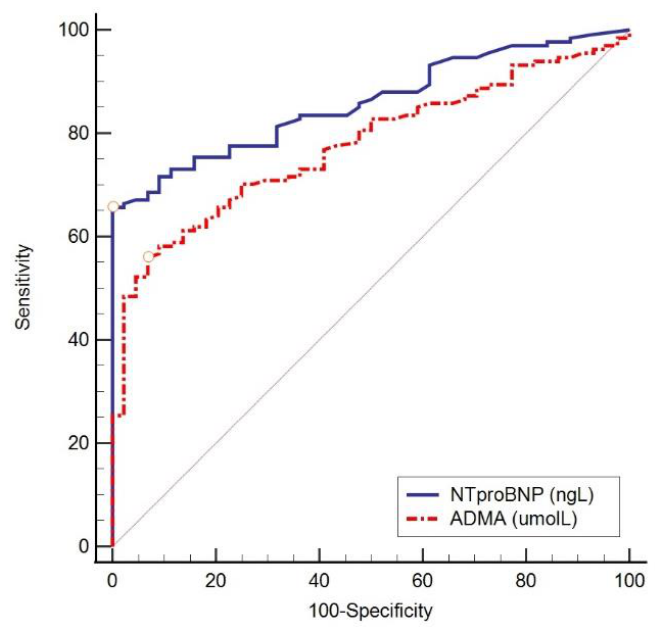
Figure 1. ROC curve comparing NT-proBNP and ADMA in different groups of subjects with normal LVDF and any form of LVDD. NT-proBNP was a better diagnostic indicator of the existence of any grade of LVDD (AUC of 0.859, 95% CI 0.807 – 0.912, sensitivity 65.7%, specificity 100%, cut-off values > 141 ng/L, Youden index 0.66, p < 0.001) compared to ADMA (AUC 0.777, 95% CI 0.708 – 0.845, sensitivity 56%, specificity 93.2%, cut-off values ≤ 0.392 µ mol/L, Youden index 0.49, p < 0.001).